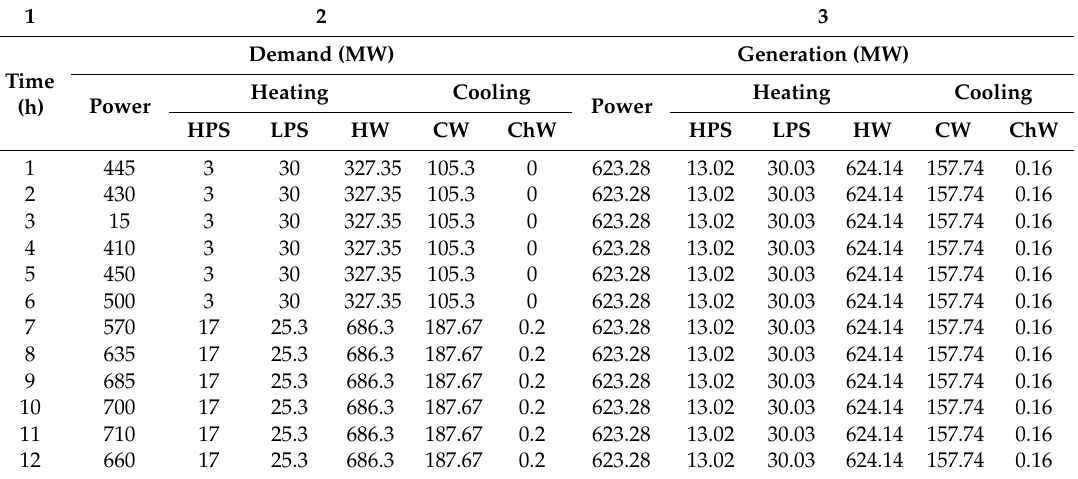
Table A9. TriGenSCA after iteration from time 1 to 12